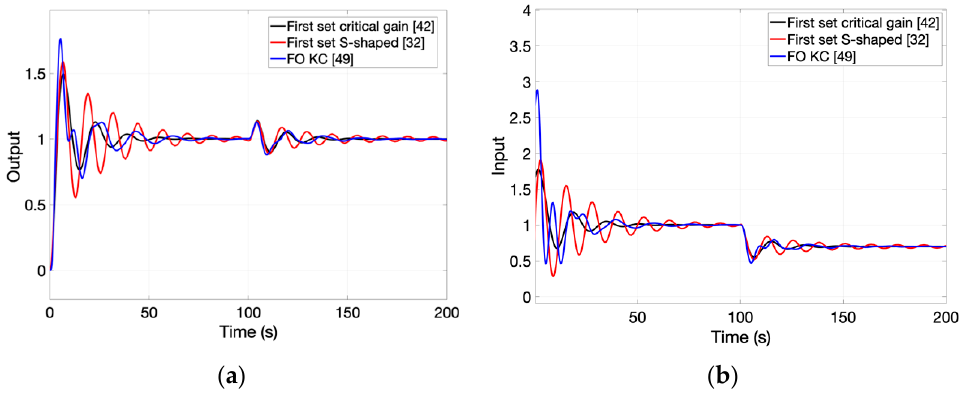
Figure 13. ( a ) Output signals for FO-PID control of higher order process ( b ) Input signals for FO-PID control of higher order process (controllers tuned according to [32,42,49]).